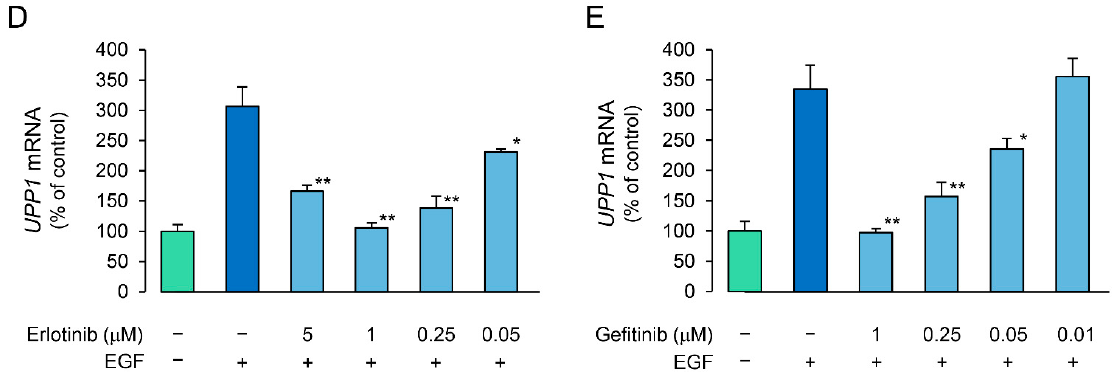
Figure 4. Inhibitory effects of receptor tyrosine kinase (RTK) inhibitors on HGF- and EGF-induced enhancement of UPP1 mRNA expression. HepG2 cells were pretreated with SU11274 (5 µ M), a